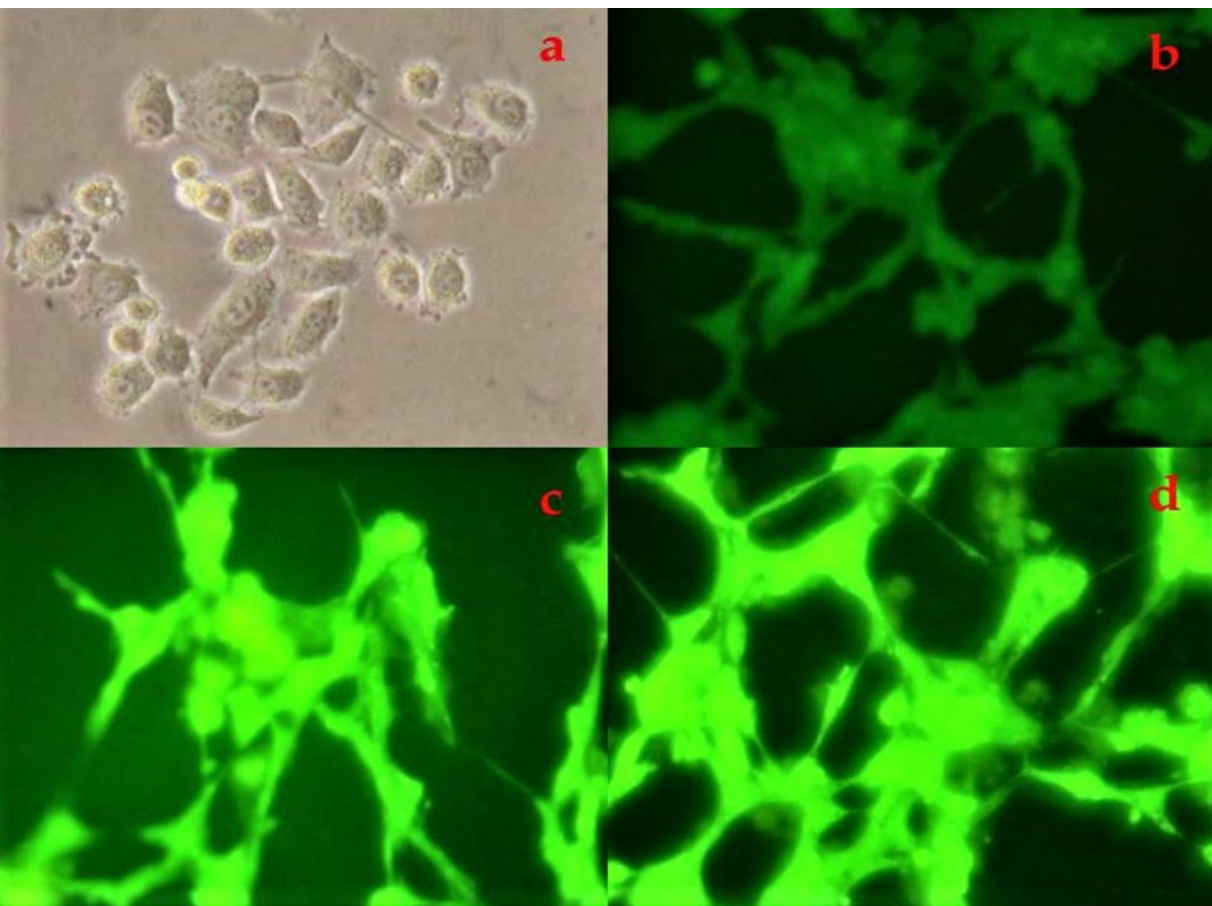
Figure 10. ( a ) Morphology of MCF-7 cancer cell line. ( b ) control, ( c ) Staphylococcal hyaluronidase treated cell. Proliferation of MCF-7 cells was significantly inhibited by Staphylococcal hyaluronidase. There was a 100% cell death at 80 µ g/mL concentration of Staphylococcal hyaluronidase in MCF-7 cells. A 40 µ g/mL of Staphylococcal hyaluronidase the anticancer activity was recorded without cell death. ( d ) Standard Paclitaxel treated. Microscopic images show the intracellular ROS in MCF-7 cells representing high DCF fluorescence. The maximum generation of ROS capacity of Staphylococcal hyaluronidase in MCF-7 was very nearer to the maximum generation of ROS capacity of standard drug